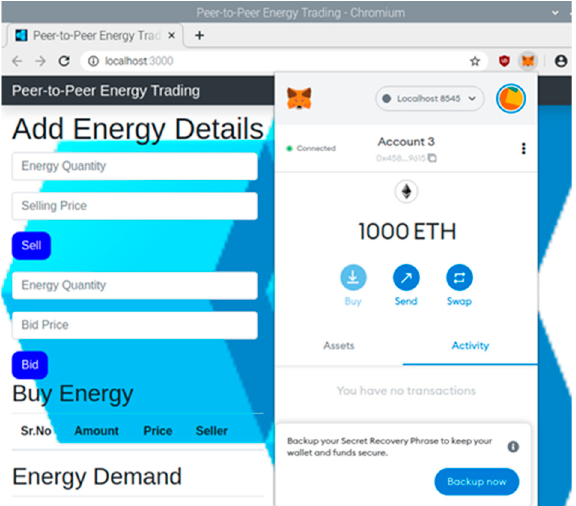
Figure 6. User interface for peer ‐ to ‐ peer energy trading.